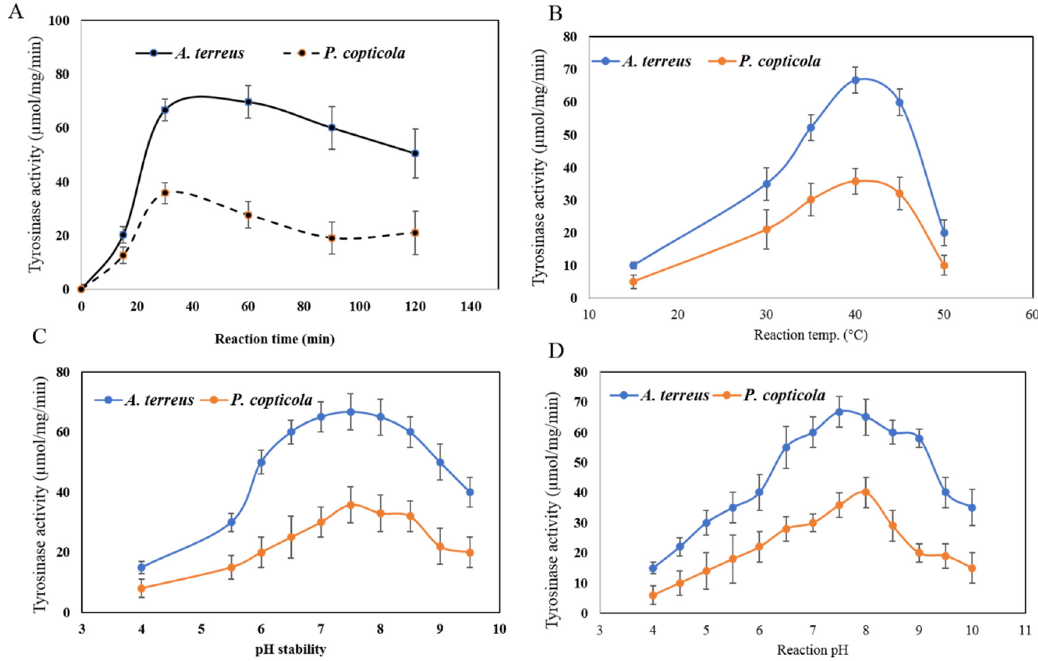
Figure 4. Biochemical properties of the purified tyrosinase from A. terreus and P. copticola. The effect of reaction time ( A ), reaction temperature ( B ), pH stability ( C ), and reaction pH ( D ) on the purified tyrosinase from both fungal isolates.